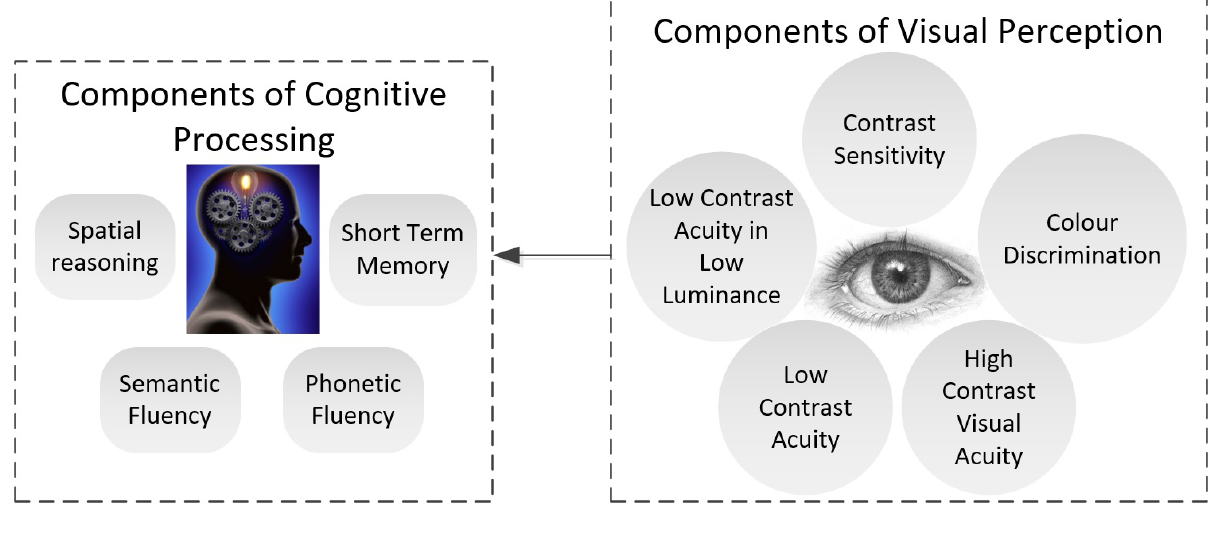
Table 2. Battery of tests. Visual perception [16].High contrast acuity [18].Low contrast acuity surface.Low contrast acuity in low luminance